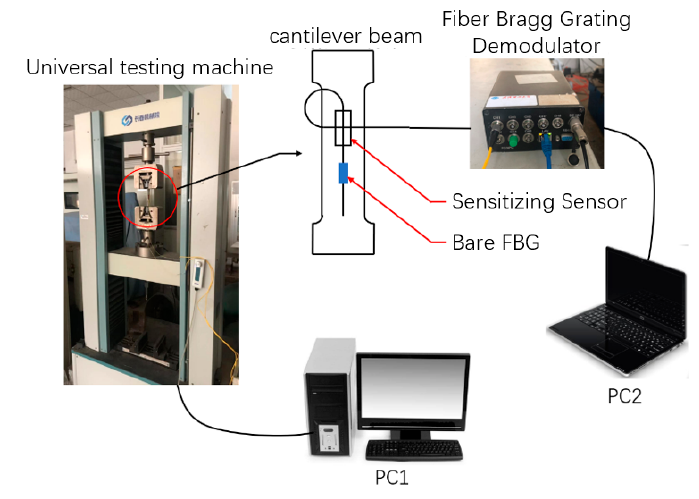
Figure 9. Experimental platform construction.